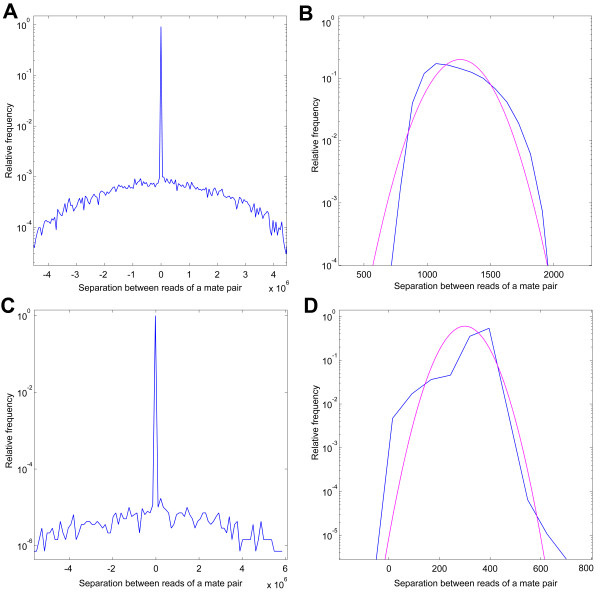
Histogram of separation between locations of two reads of a mate pair on the reference genome. This histogram appears to be a combination of two parts. One part is a distribution peaked around the insert size of the mate pair library, as expected. However, in addition, there is a broad background. (A) E. coli data from SOLiD platform. (B) E. coli dataset, but limited to pairs for which the separation is around the peak region in (A). (C) P. syringae data from Illumina platform. (D) P. syringae dataset, but limited to pairs for which the separation is around the peak region in (C). Both distributions in (B) and (D) have large standard deviations, each around 20% of the corresponding mean values.